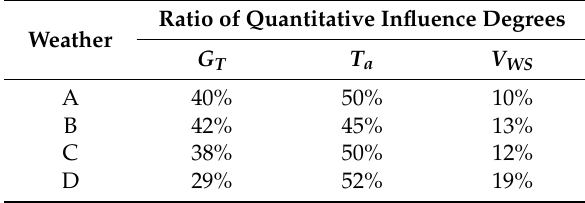
Table 4. Ratio of quantitative influence degrees measured by correlation coefficient.